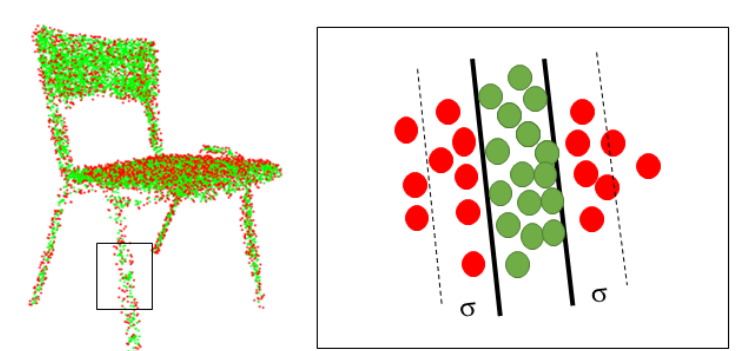
Figure 9. Calculation of the SD of FP points σ on the example of a chair. Green TP points are within the object boundaries. The red FP points were added to the chair class but actually belong to another class.